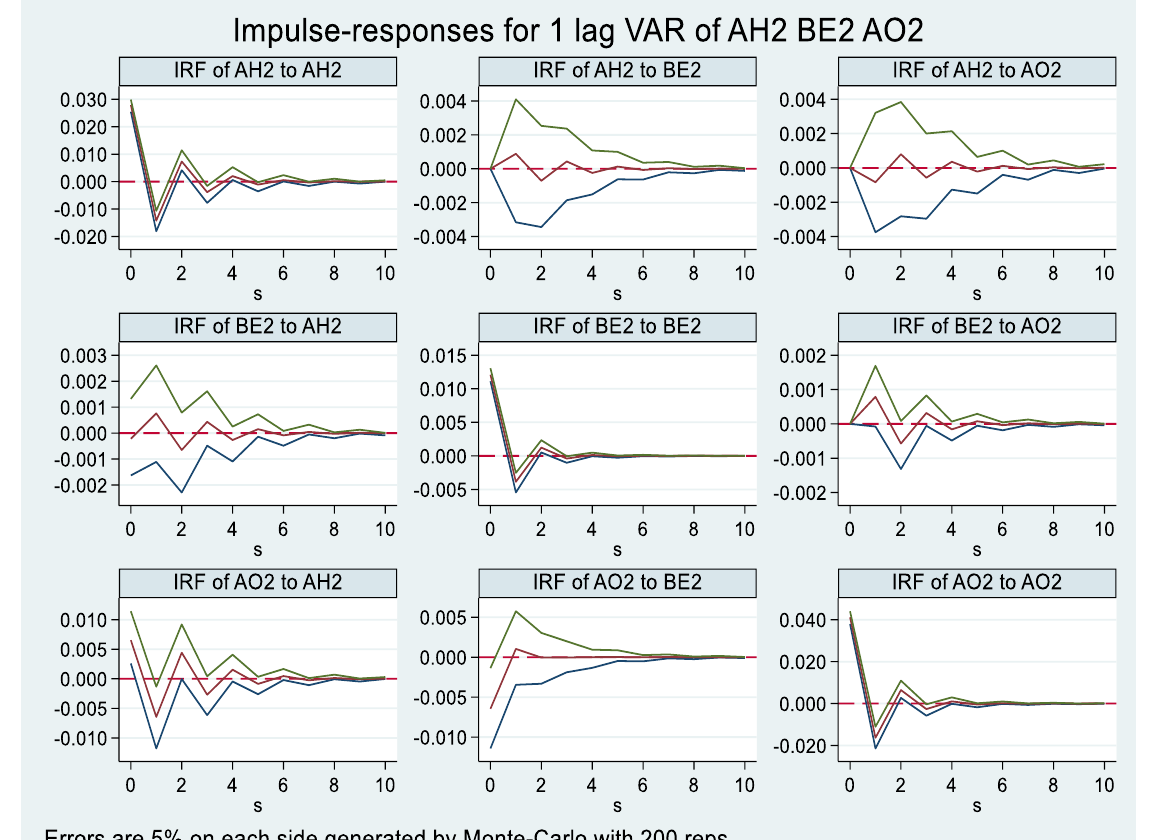
Figure 4. Impulse response diagram of AH2, BE2 and AO2.